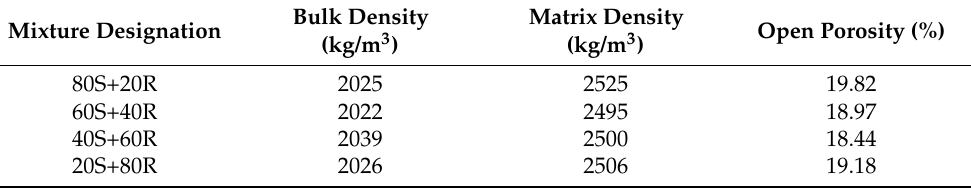
Table 3. Basic material properties of the